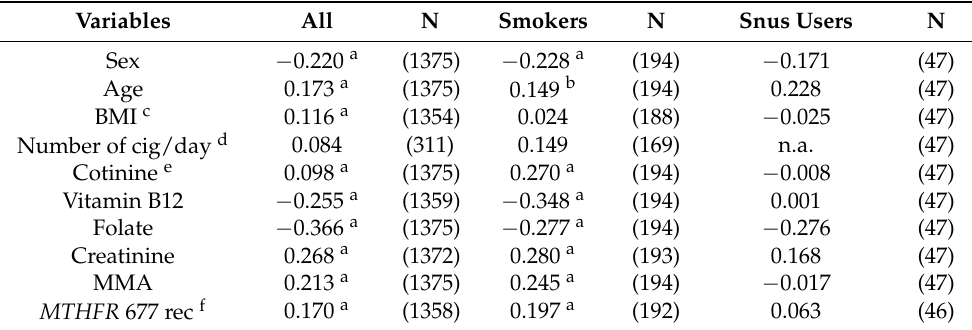
Table 2. Spearman’s rho correlations between tHcy and other